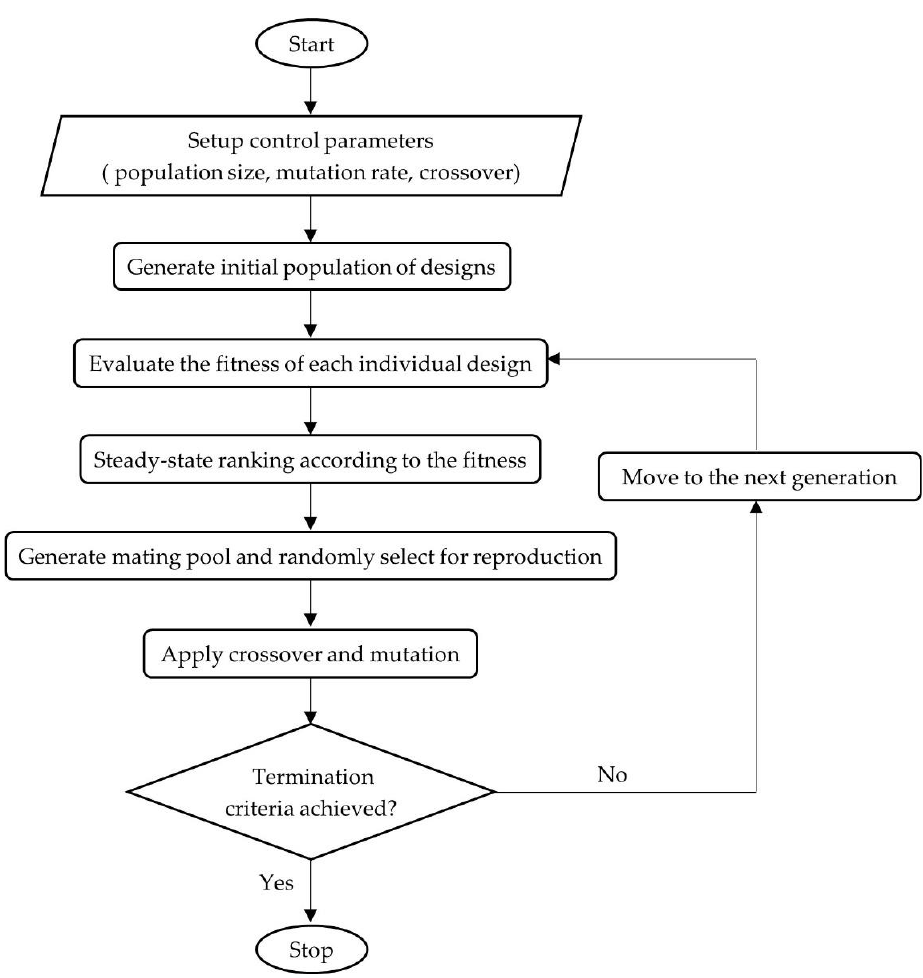
Figure 1. Flowchart of Evolver’s GA methodology.